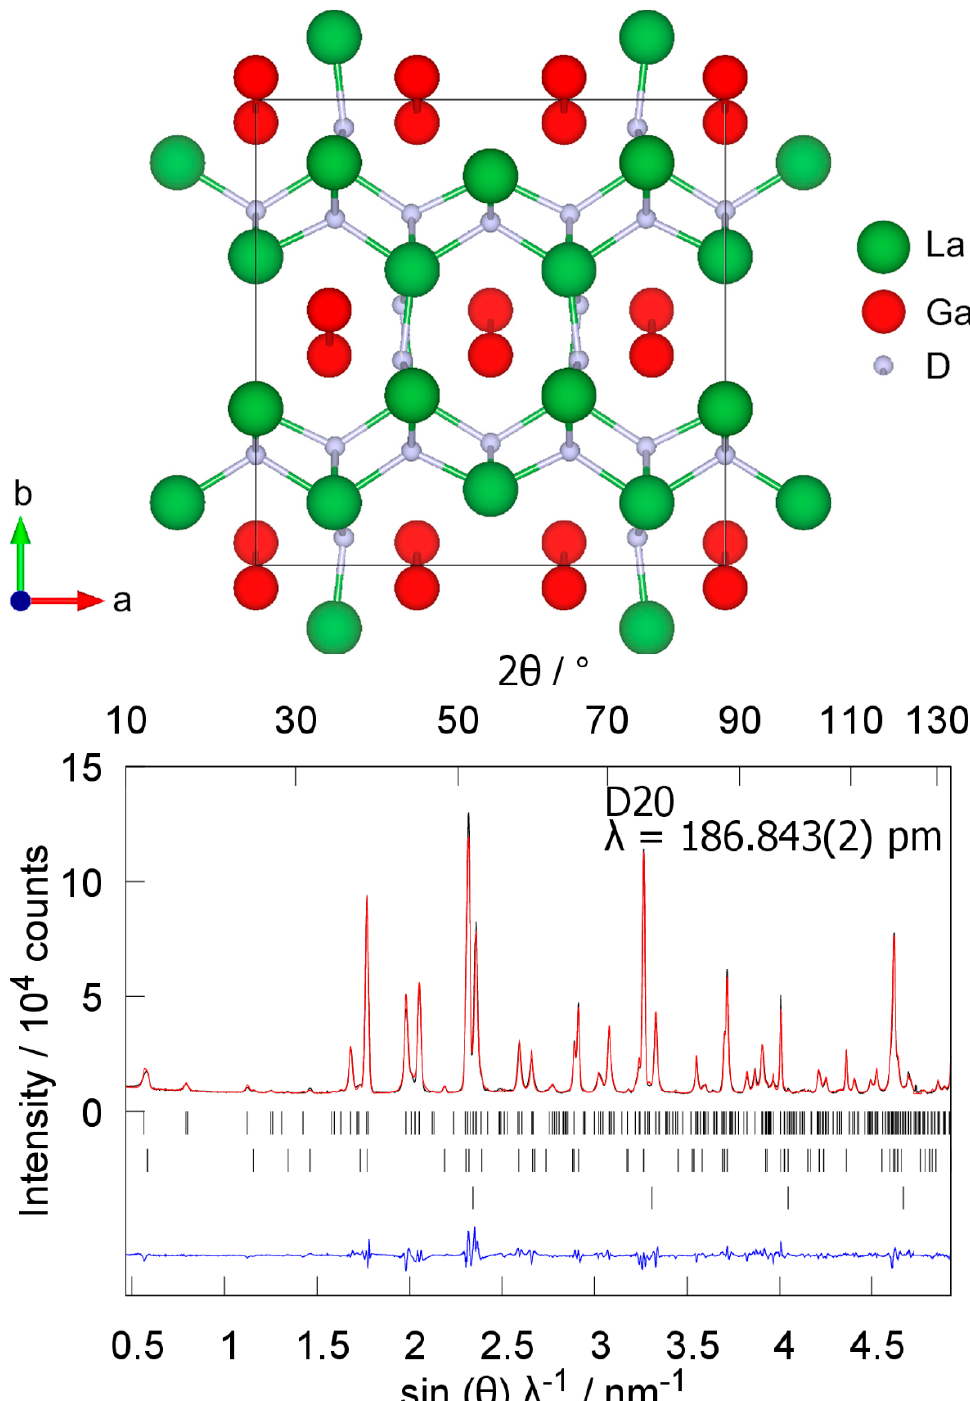
Figure 3. Top : crystal structure of LaGaD 1.63(1) ; bottom : Rietveld refinement of the crystal structure of LaGaD 1.63(1) using neutron powder diffraction data, Bragg marker from top to bottom: LaGaD 1.63(1) (57.7(7)%), LaGa 2 D 0.71 (45.3(5)%), V (sample container), R p = 4.55%, R wp = 6.05 %, GooF = 7.16.